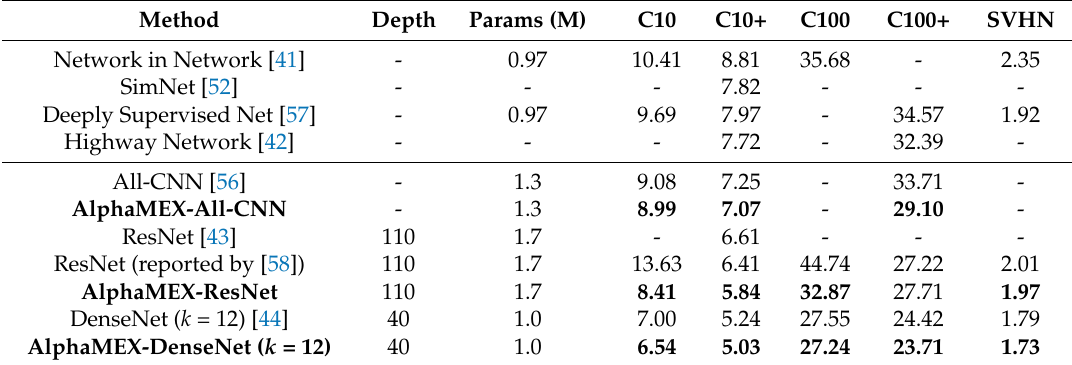
Table 2. Error rates (%) on CIFAR-10/CIFAR100 (C10/C100) and SVHN datasets. Standard data augmentation (translation and/or mirroring) is indicated by “+”. The number of model parameters is given in million. AlphaMEX Global Pool-based structures (in bold) achieve lower error rates than each compared state-of-the-art structures without adding redundant layers or parameters.